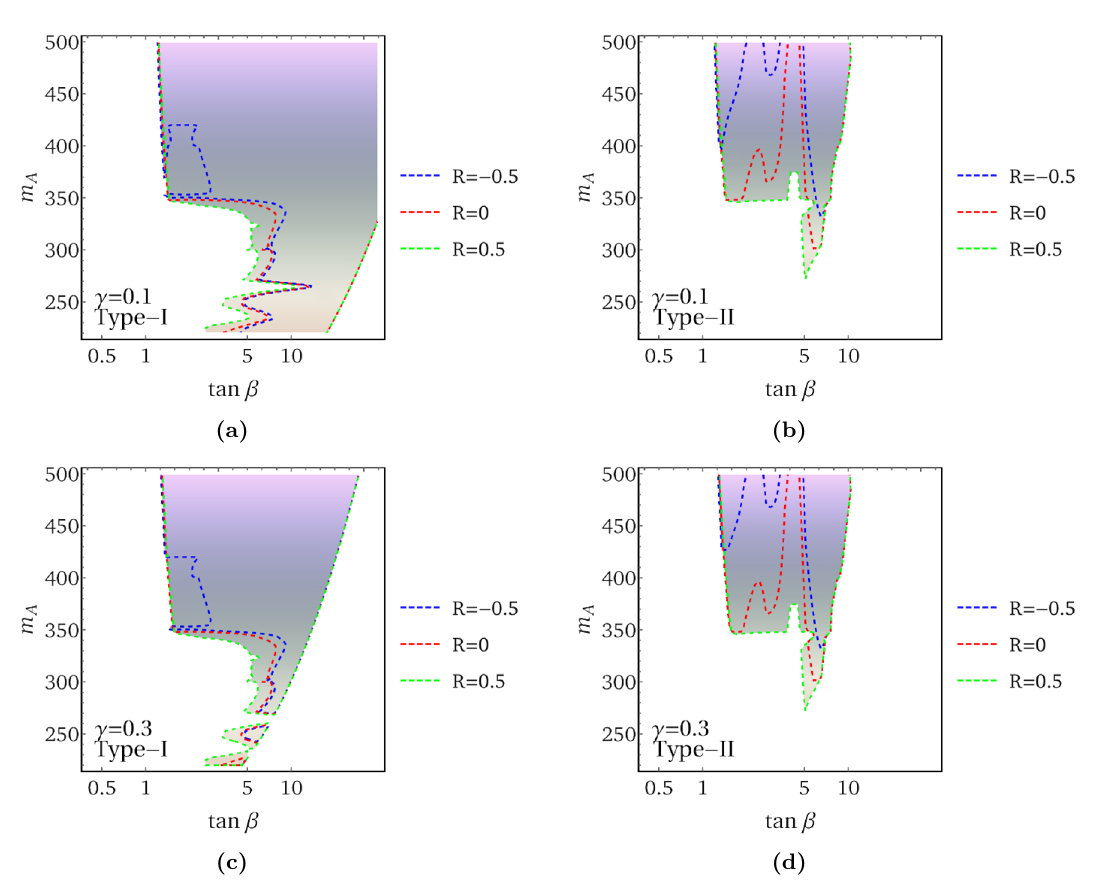
Figure 6. Regions allowed by experimental bounds and tuning constraints for different R , with an m 2 and ∆ m 2 tuning of at most 5% . Each panel shows three different R curves; the white regions 12 of the parameter space are ruled out. The ruled out areas expand somewhat as R decreases, with the borders of the allowed shaded regions indicated by the corresponding contours. For R = − 0 . 5 , the area enclosed by the closed dashed blue contour in panel (a) is also ruled out. Panels (a) and (c) correspond to Type-I Yukawa couplings, and panels (b) and (d) correspond to Type-II Yukawa couplings. Panels (a) and (b) employ the γ = 0 . 1 benchmark, whereas panels (c) and (d) employ γ = 0 . 3